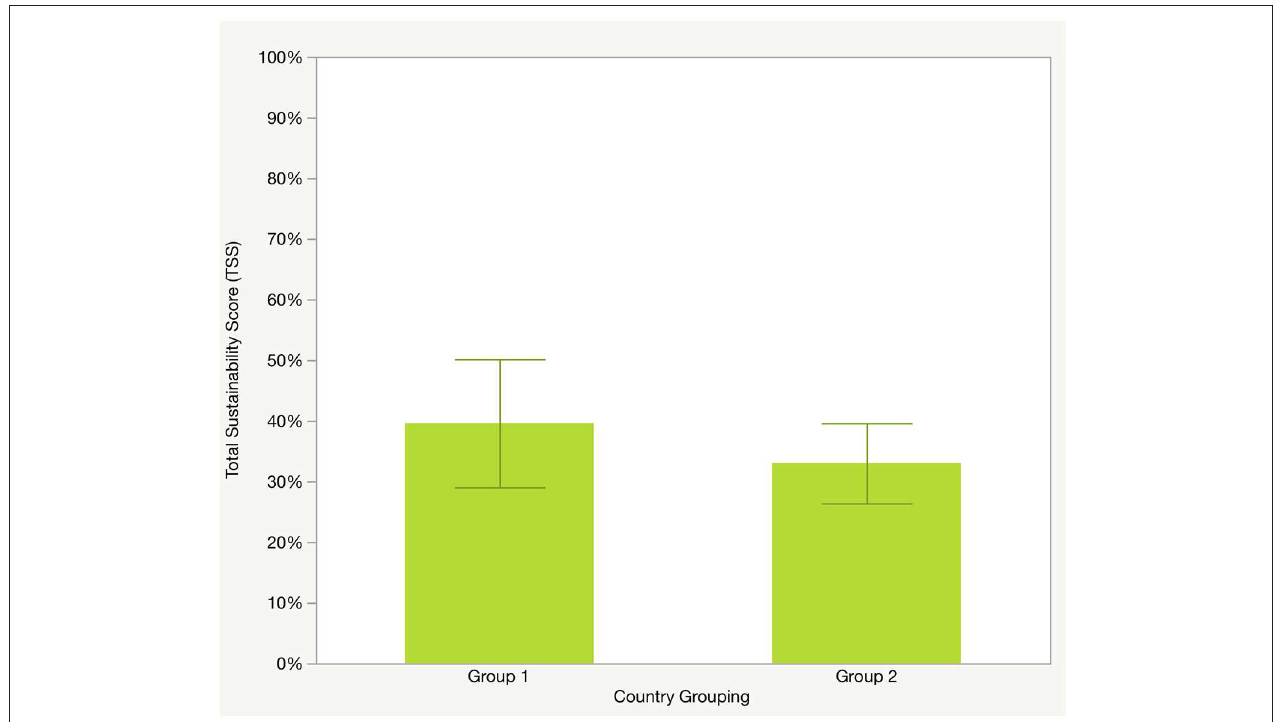
FIGURE 7 | Variation of total sustainability dimension scores (TSS) of national dietary guidelines between country groupings. This figure demonstrates the variation of total sustainability dimension scores comprised of the 32 sub-dimensions of sustainability between countries classified as Group 1 (recognized in the literature to integrate sustainability in dietary guidelines) compared to Group 2. Analysis of variance of TSS between Group 1 and Group 2 found no significant